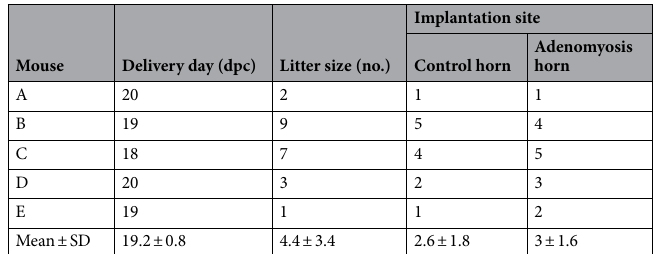
Table 2. Adenomyosis pregnancy model.